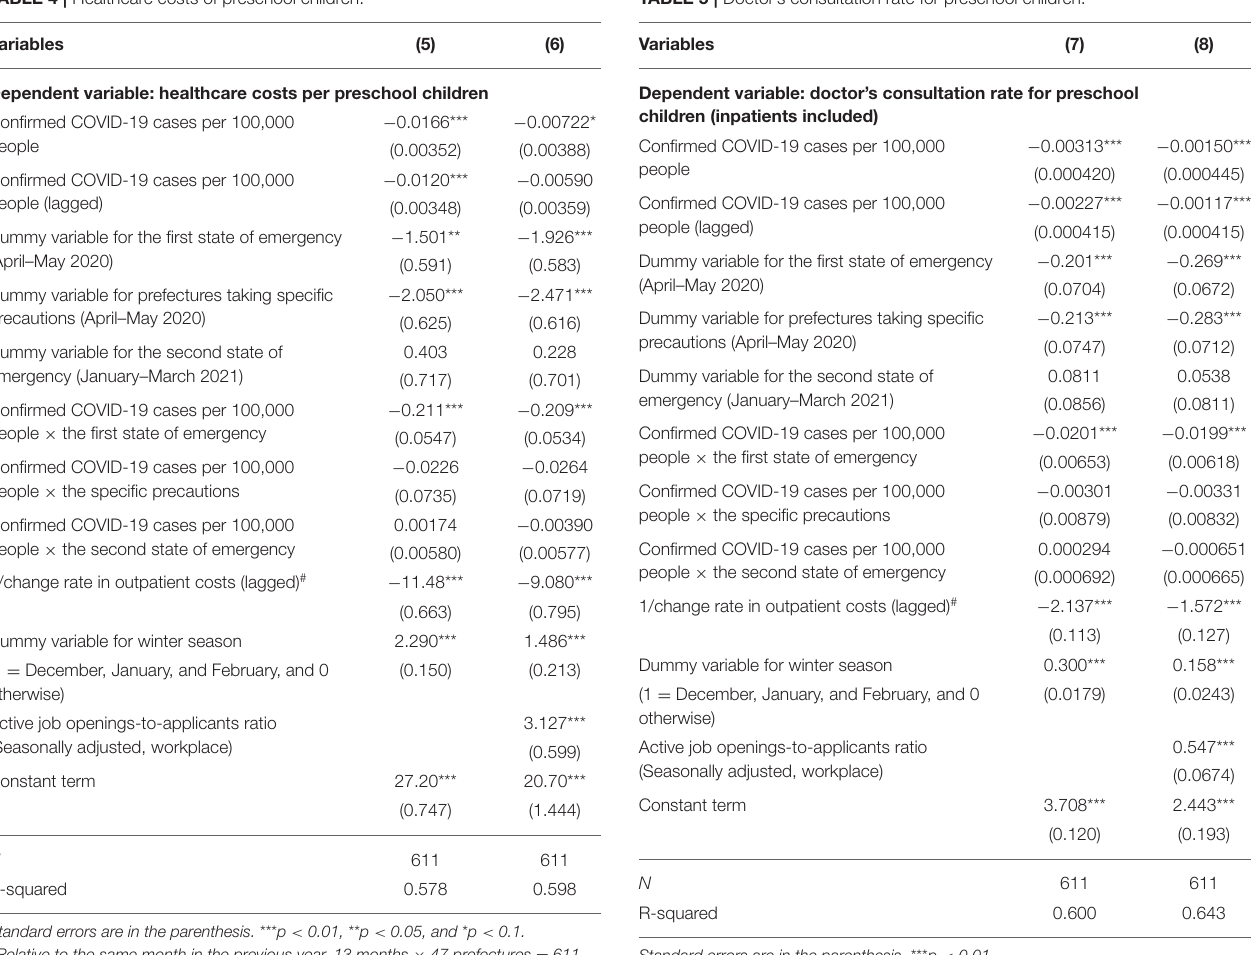
TABLE 4 | Healthcare costs of preschool